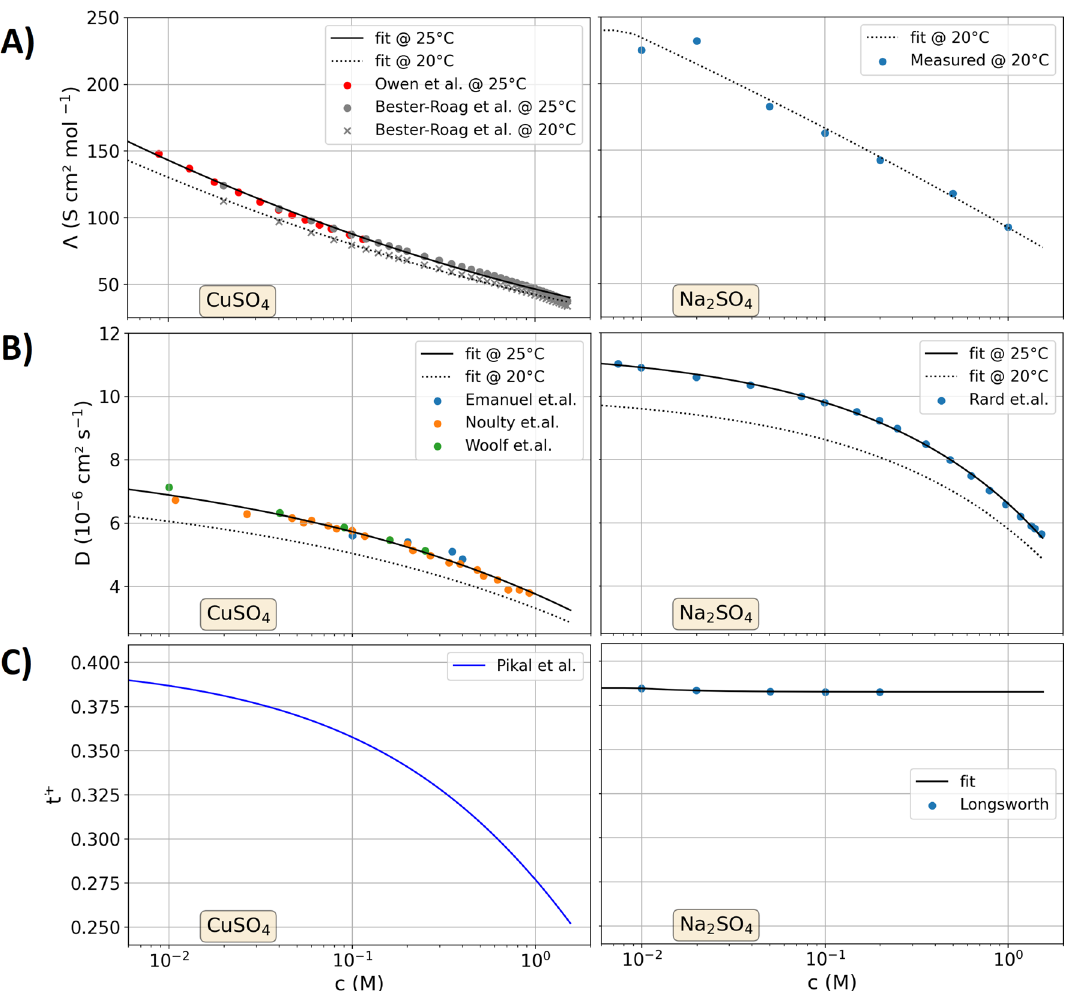
Figure 1. Parameterization of CuSO 4 (left) and Na 2 SO 4 (right) binary electrolytes as a function of the concentration. ( A ) Molar conductivity. ( B ) Diffusion coefficient. ( C ) Transfer